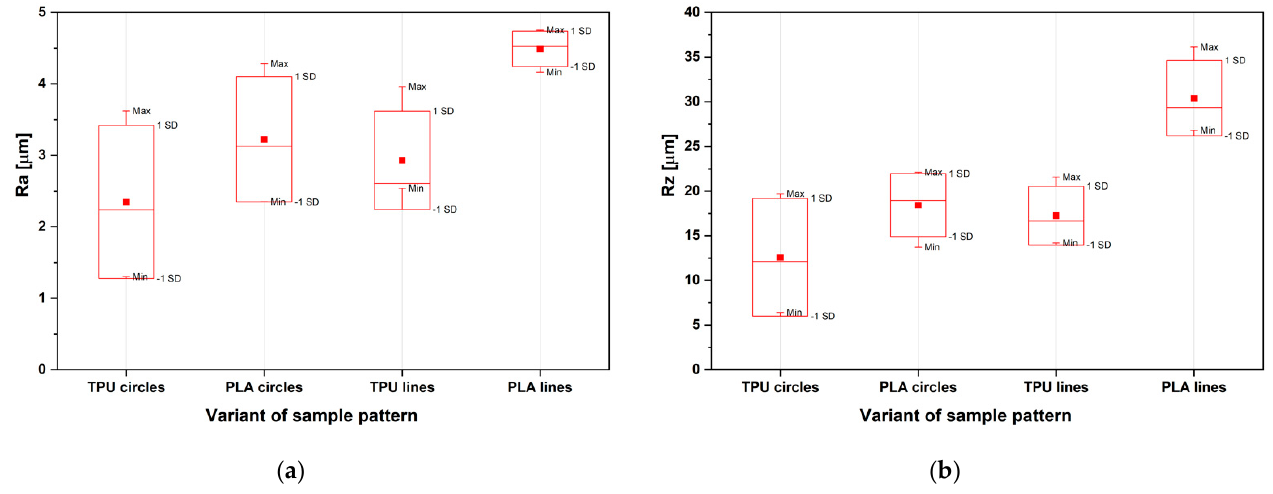
Figure 10. Roughness results measured by Hommel-Etamic T8000, according to PN-EN ISO 4287:1999 ( a ) Ra parameter in micrometers ( b ) Rz parameter in micrometers.